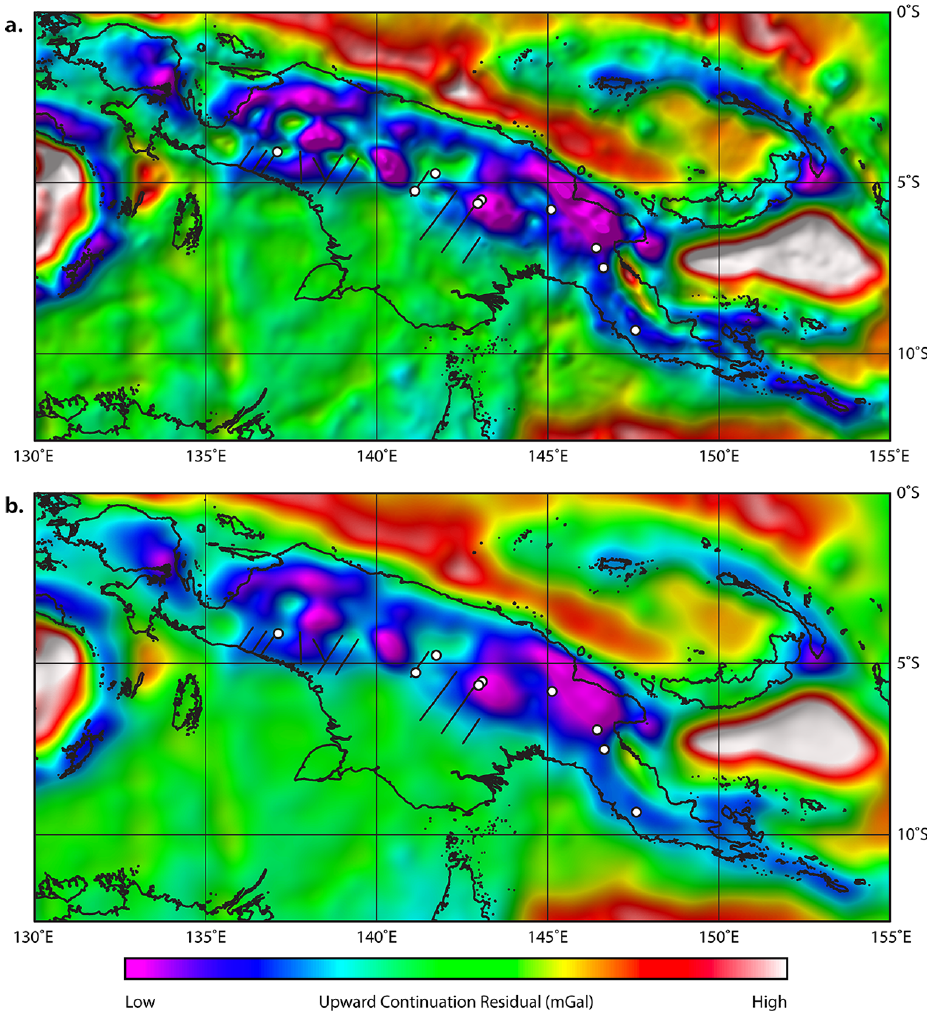
Fig. 8. Upwards continuation residual (UCR) filter applied to the BGI Bouguer gravity data. The Bouguer gravity data were calculated as if they were collected by a measurement at 20, 40, 80 and 100kma.s.l., and new grids were produced by: (a) subtracting the 80km grid from the 20km grid, and (b) subtracting the 100km grid from the 40km grid. The illumination direction that was used in (a) and (b) is from the southeast. This was used to highlight any NNE-trending structures. The same grids were generated with different illumination angles to interpret lineaments with other orientations. The location of major Au/Cu/Ag/Mo deposits is shown as white circles (See Fig. 1a for more details). The NNE-trending lineaments that were proposed by Hill (1991) and Kendrick et al. (1995) are shown as thin black